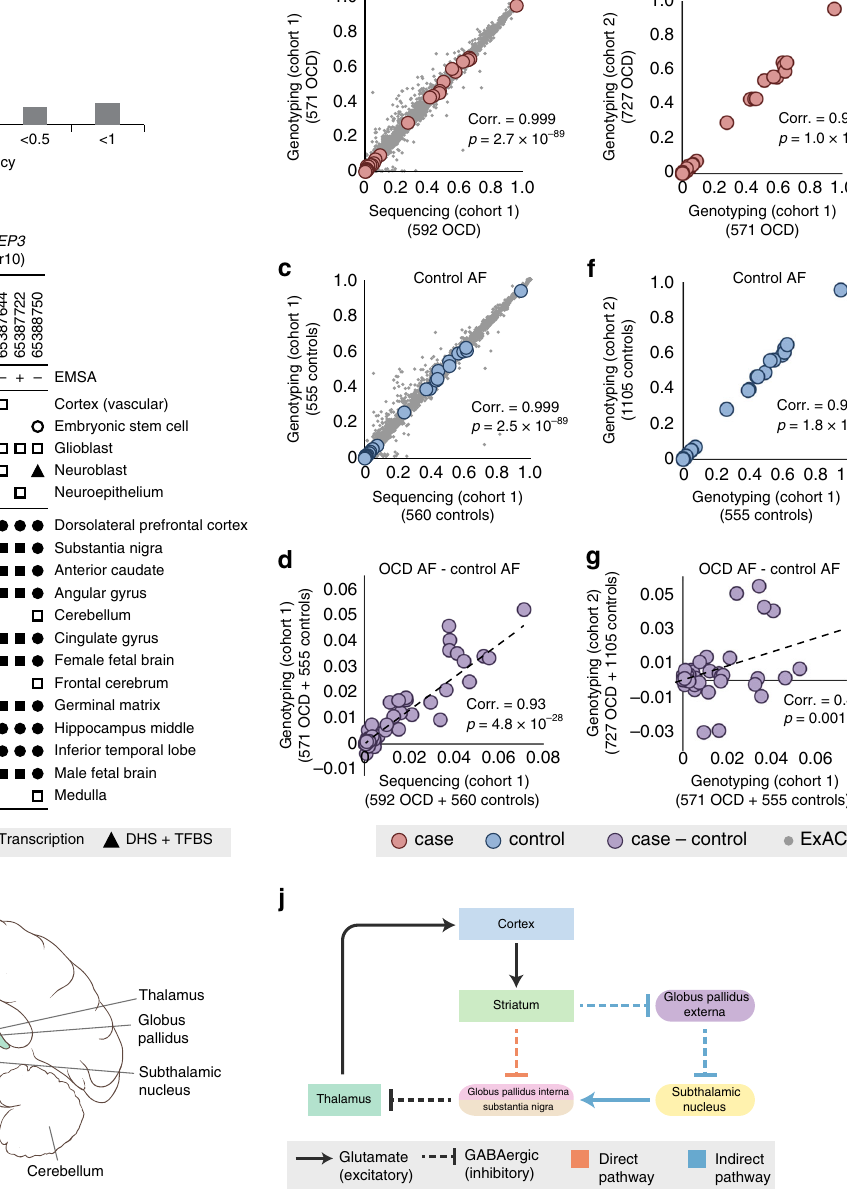
Fig. 3 Validated top candidate variants disrupt functional elements active in brain. a Frequencies of the top candidate variants show that most are rare (AF < 0.01) in our cohort, illustrating the value of sequencing rather than array-based genotyping for detecting candidate variants. b – g Allele frequencies from pooled sequencing of individuals in the original cohort (cohort 1) are validated by genotyping in b cases and c controls, and by d allele-frequency differences between cases and controls. For the vast majority of variants, the pooled-sequencing allele frequencies are also highly correlated with frequencies observed in 33,370 ExAC individuals in both cases ( b , gray dots ) and controls ( c , gray dots ). Genotyping an independent cohort (cohort 2) of cases and controls reveals genotyping allele frequencies from cohort 1 are correlated in e cases and f controls; and for g allele-frequency differences between cases and controls. Correlation test was performed using Fisher ’ s Z transform. h The top candidate variants in CTTNBP2 and REEP3 , the two genes enriched for regulatory variants, disrupt DNase hypersensitivity sites ( DHS ), enhancers, and transcription factor-binding sites (TFBS) annotated as functional in brain tissues and cell lines in ENCODE and Roadmap Epigenomics. All 17 variants disrupt elements active in either the dorsolateral prefrontal cortex and/or substantia nigra, which are among the i brain regions involved in the CSTC circuit implicated in OCD, illustrated with black arrows . Image adapted from Creative Commons original by Patrick J. Lynch and C. Carl Jaffe, MD. j The CSTC circuit requires a balance between a direct,